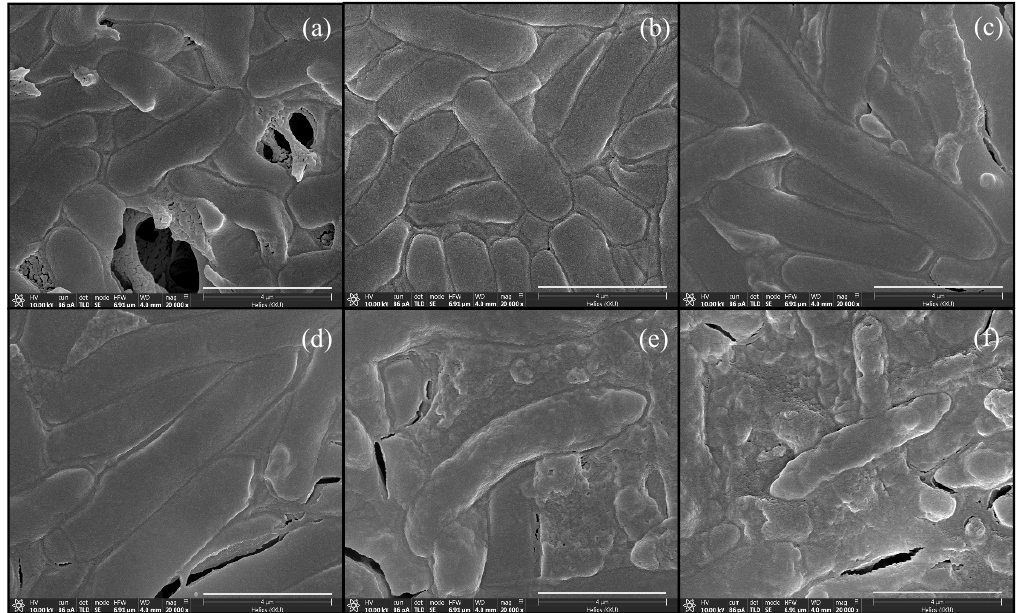
Figure 4. FE-SEM micrograph of C. beijerinckii TISTR 1461 during ABE fermentation in SSJ medium by a single culture at 0 h ( a ), 12 h ( b ), 24 h ( c ), 36 h ( d ), 48 h ( e ) and 60 h ( f ) of fermentation. Magnification of 20,000×. Scale bar: 4 µm.